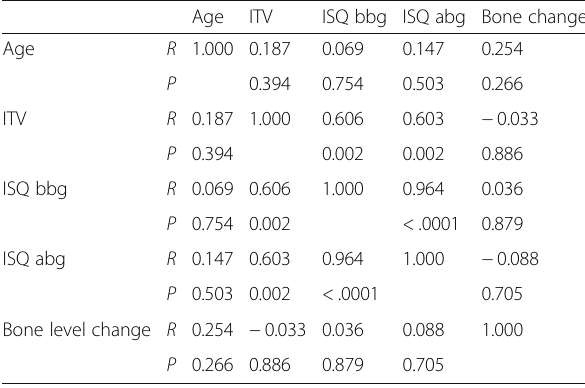
Table 2 Pearson ’ s correlations among patient age, implant stability parameters, and peri-implant bone changes